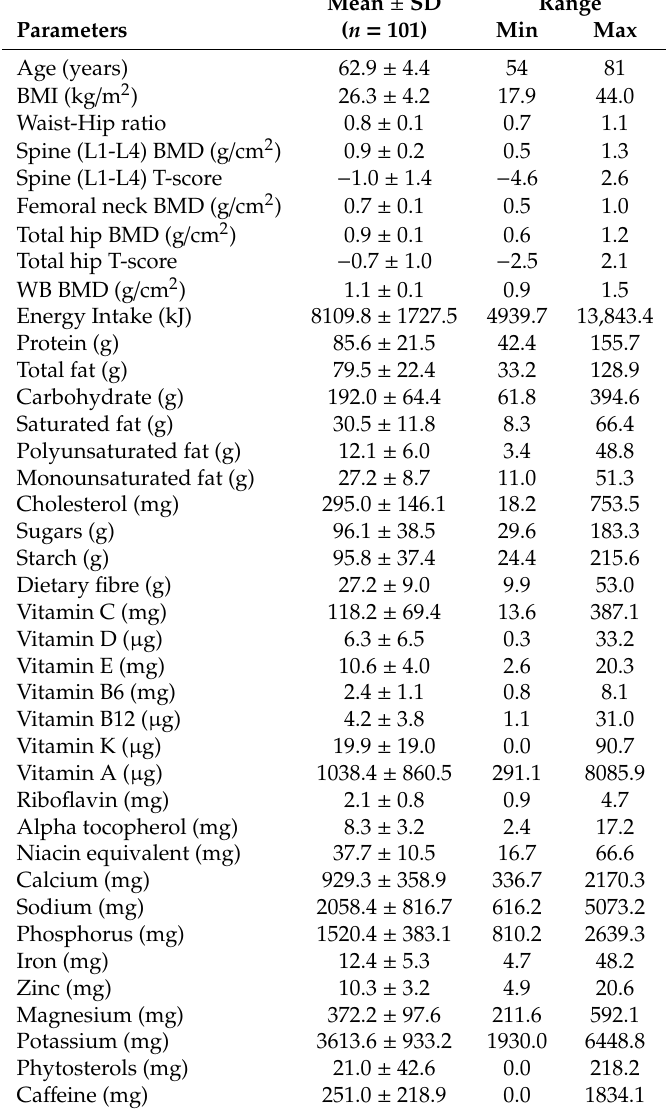
Table 1. General characteristics and nutrient intakes of 101 participants based on